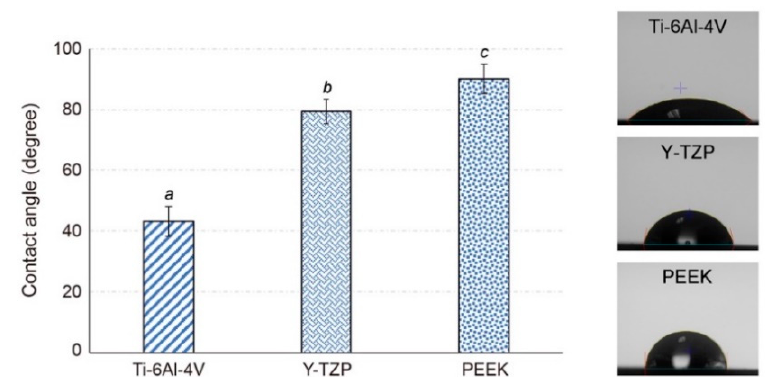
Figure 4. The contact angles results and the representative images of different dental material groups (different letters (a,b,c) indicate groups statistically different, p < 0.05).